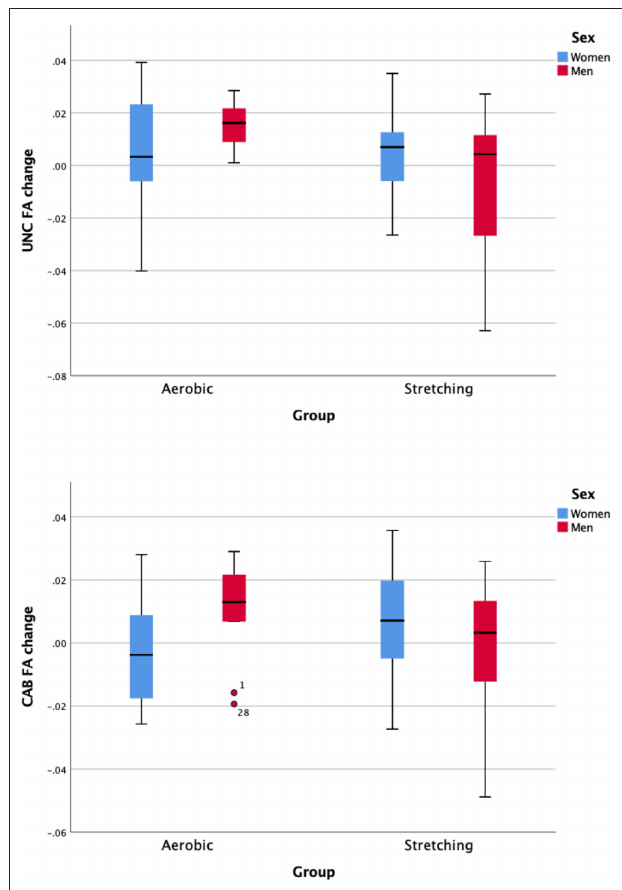
FIGURE 2 | Sex-difference of the intervention effect in terms of change on the white matter tract fractional anisotropy of the uncinate fasciculus (UNC) and the Cingulum—angular (infracallosal) and bundle